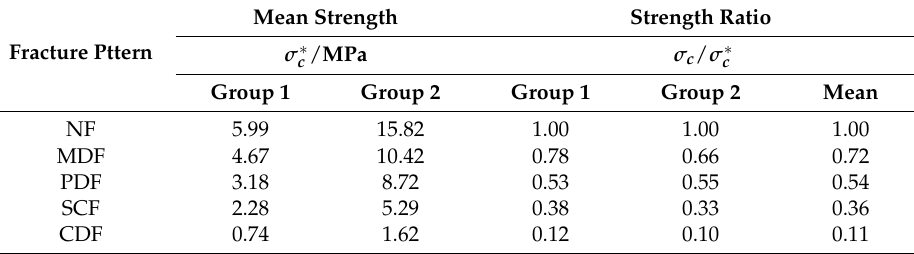
Figure 5. Strength distribution. Table 2. Compressive strength of intact and fractured coal.